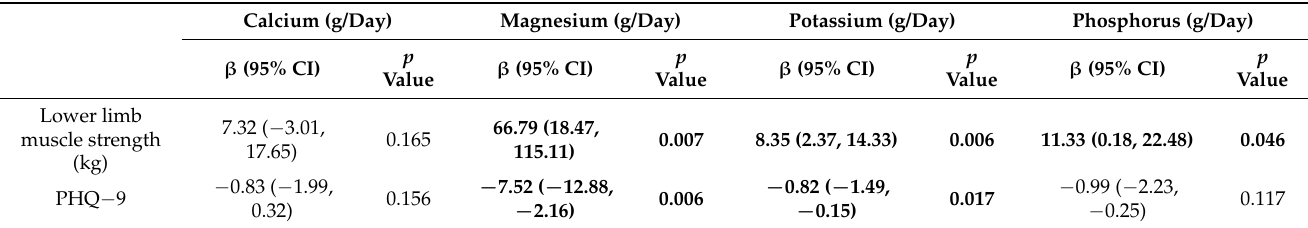
Table 5. Associations of macroelements with OA comorbid conditions over 2